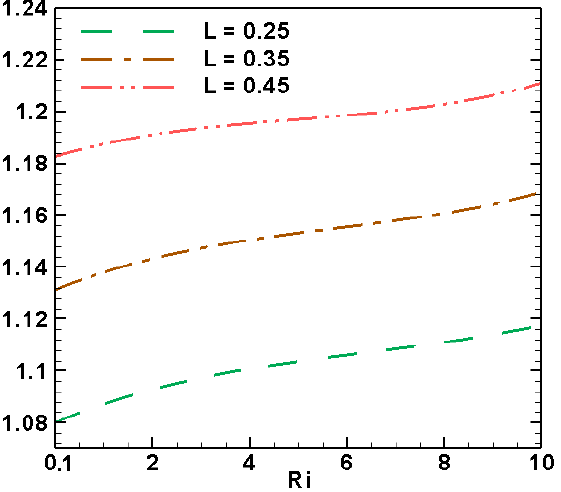
Figure 10. Fin effectiveness for different Ri and L at Ha = 20, Re = 100, and λ = 2.